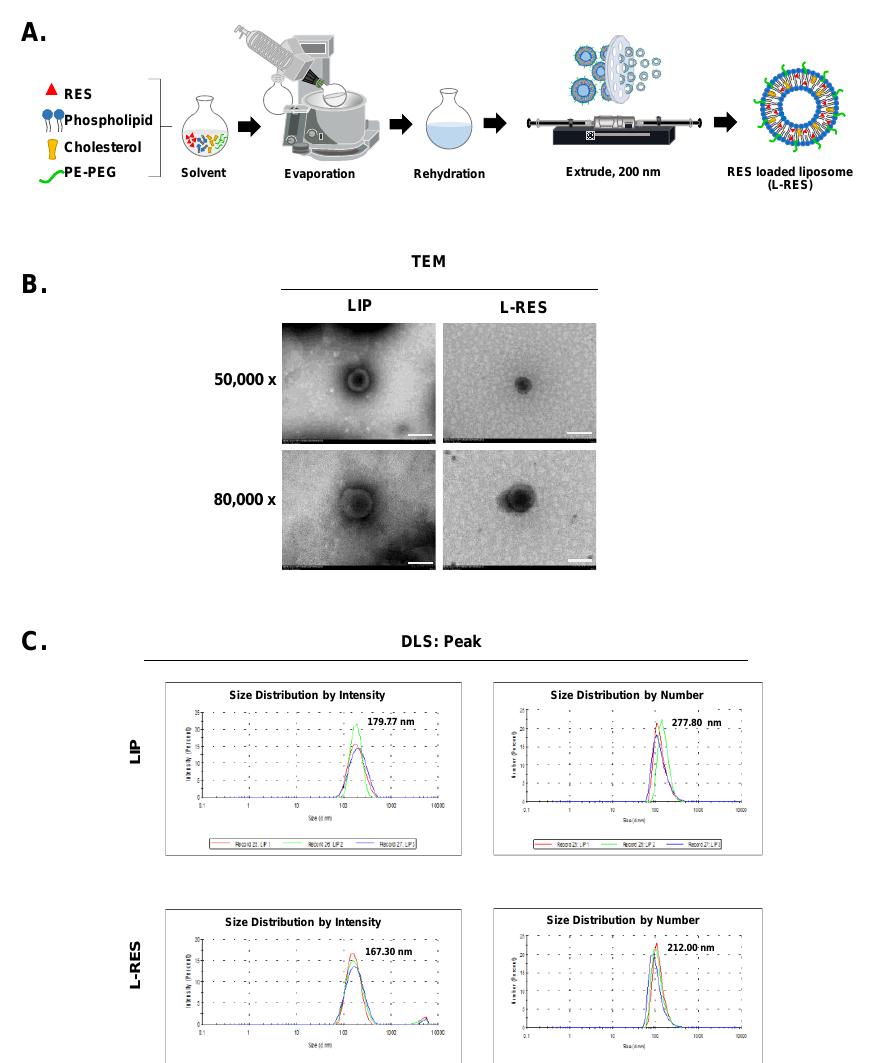
Figure 1. Formulation and morphology of resveratrol-loaded liposome (L-RES). ( A ) The L-RES was formulated using the thin film method. ( B ) Morphology of the formulated L-RES was observed un- der transmission electron microscopy (TEM) with magnifications 50,000× and 80,000×; scale bar = 200 nm. ( C ) Peak of average diameter of L-RES as determined by dynamic light scattering (DLS). Table 1. Physicochemical properties of resveratrol loaded liposome liposomes. The hydrodynamic size, polydispersity index (PDI), and zeta potential of liposomes were measured by the dynamic light scattering. Encapsulation efficiency was determined using HPLC .